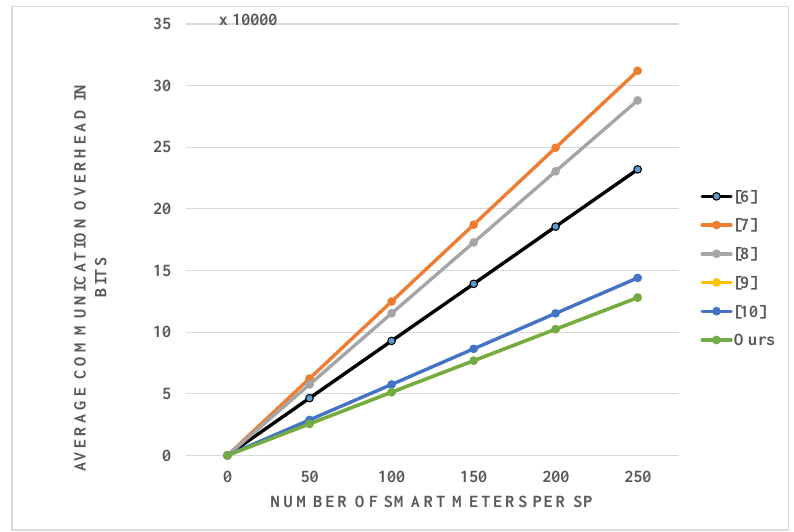
Figure 8. Total traffic volume at the SP from smart